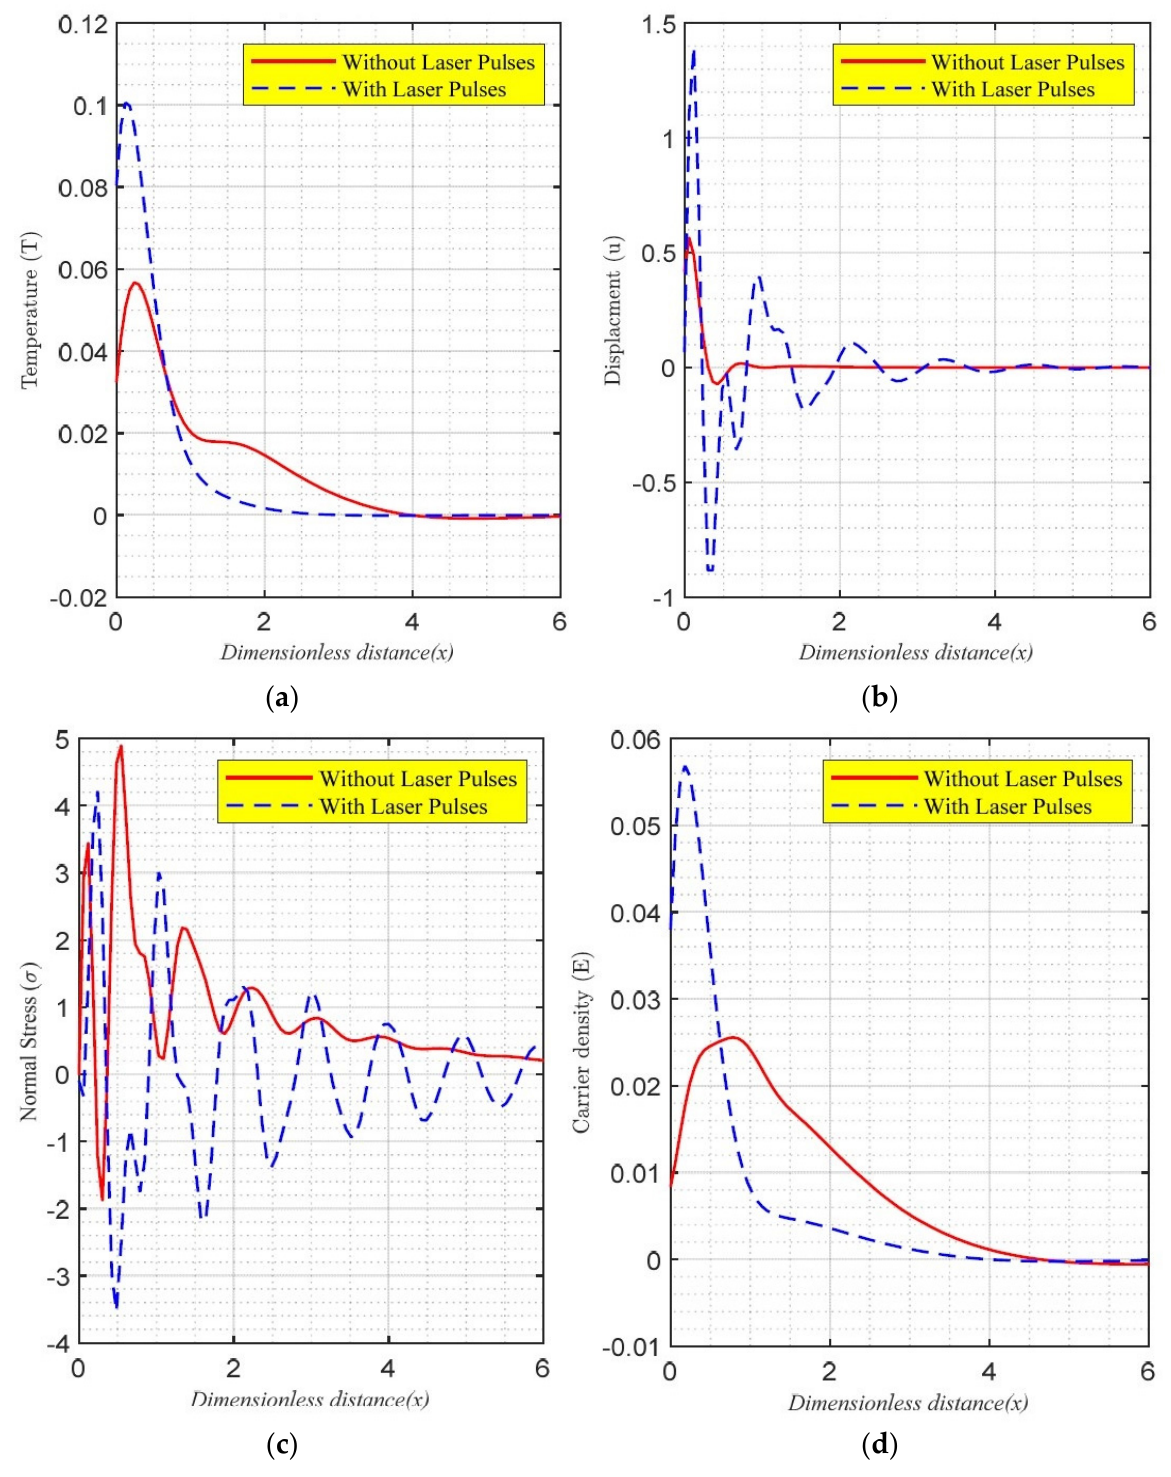
Figure 3. ( a – d ) The comparison between the physical field distributions against the distance under the impact of laser pulses and without the effect of laser pulses in the context of the DPL model for Si material.